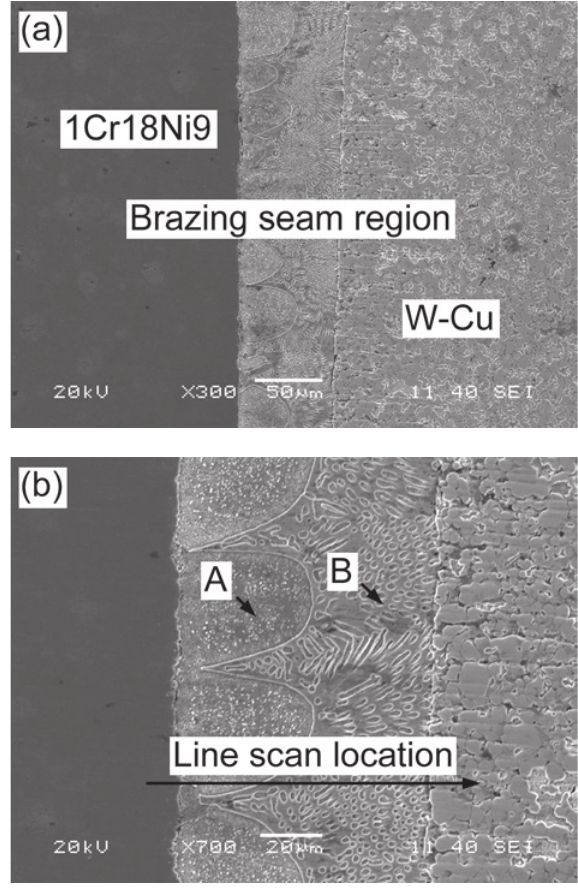
Fig. 4: EDS results of different area in brazing seam